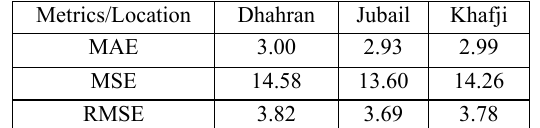
Table 2. Error metrics in Case II.